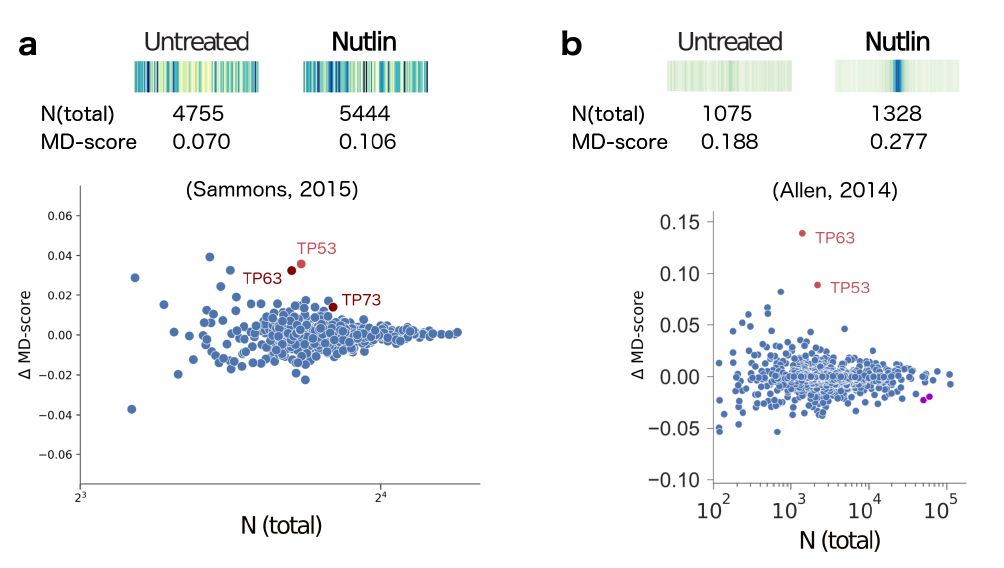
Figure 1. ( a ) Top: The motif displacement distribution as heatmap (increasingly dark blue indicates more instances of motif), MD-score and the number of motifs within 1.5 kb of an ATAC-seq peak before and after stimulation with Nutlin-3a (e.g., Nutlin) [61] for TP53, the transcription factor known to be activated. Bottom: For all motif models (each dot), the change in MD-score following perturbation (y-axis) relative to the number of motifs within 1.5 kb of any ATAC-seq peak center (x-axis). Red/maroon points indicate significantly increased MD-scores ( p -value < 10 − 5 , < 10 − 4 , respectively). ( b ) Similar analysis obtained from nascent transcription data [55], where MD-scores are measured relative to eRNA origins. Purple dots indicate significantly decreased MD-scores. Figure adapted from Azofeifa et al.